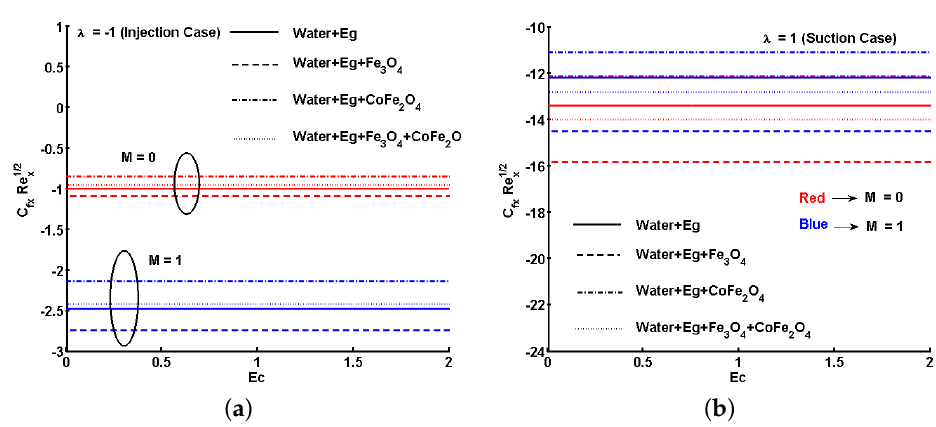
Figure 15. Effect of Eckert number ( Ec ) and magnetic parameter ( M ) on the local skin friction coefficient. ( a ) Injection; ( b ) suction.